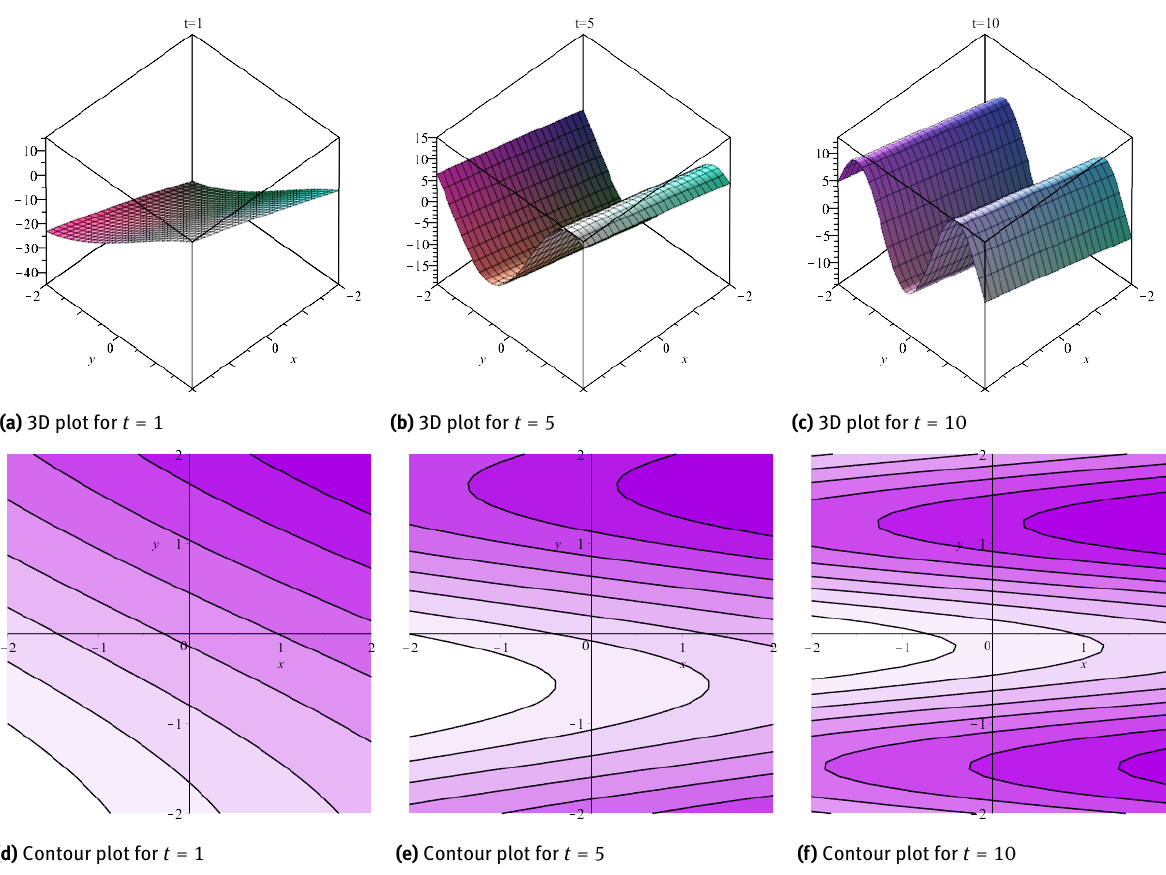
Figure 2: Solution profiles for equation (44) with n 1 = 1 , n 2 = 2 , m 3 = 3 , z = 2 and R = 20 sin ( w )